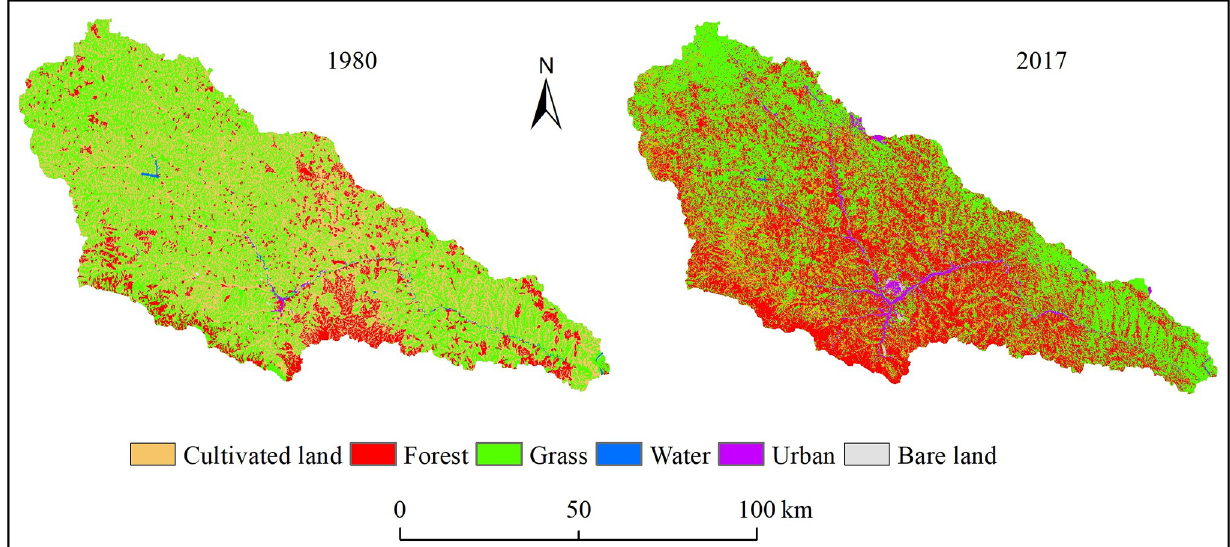
Fig 3. Land use map of the Yanhe River Basin in the different years. The map was prepared in ARCGIS using Classification of land use types from the Resource and Environment Science and Data Center (http://www.resdc.cn). The land uses of 2017 were interpreted from Landsat OLI images which were collected from the Geospatial Data Cloud